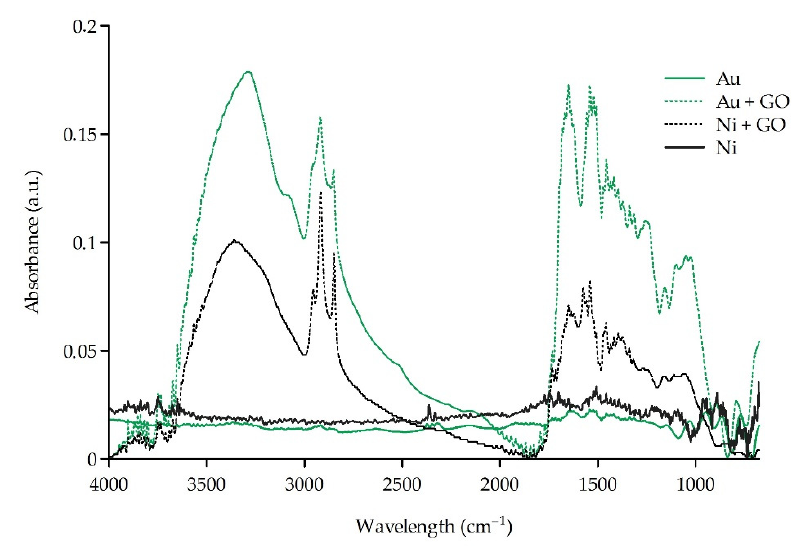
Figure 2. The FTIR spectra of the Au, Au + GO, Ni, and Ni + GO surfaces.